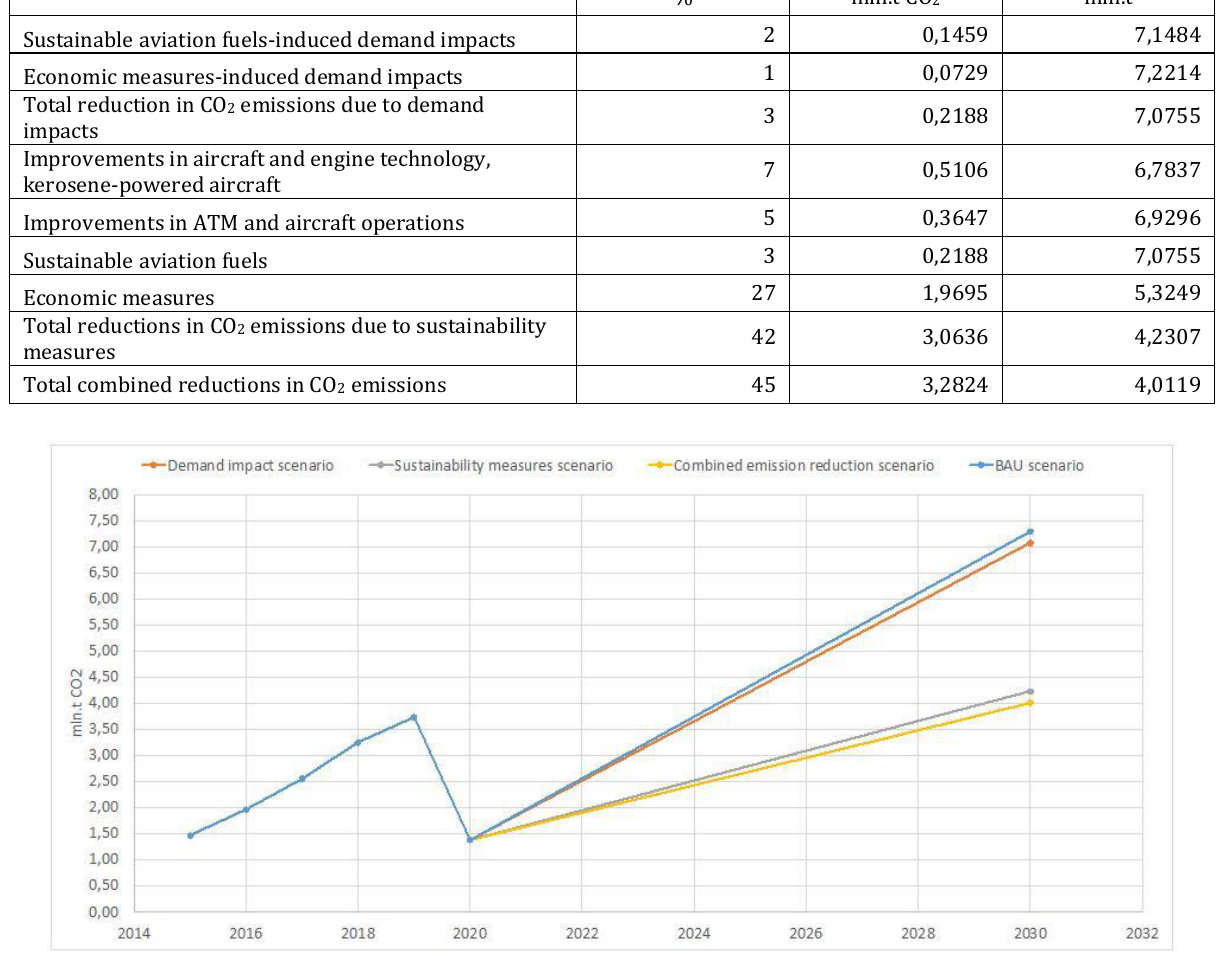
Fig. 4. Modelled CO 2 emission data according to scenarios provided for